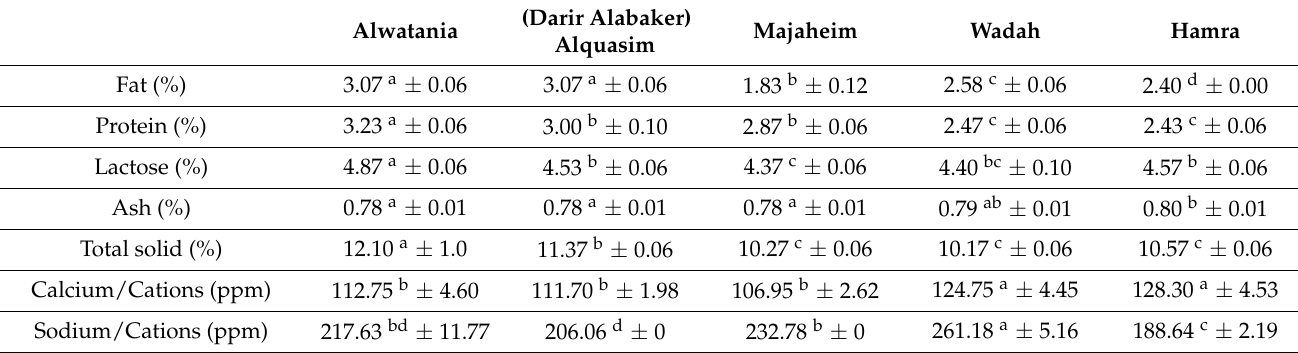
Table 1. Chemical composition of camel milk from five samples—Alwatania, Alquasim, Majaheim, Wadah, and Hamra (%: g per 100 g of milk sample). a–d Different letters in the same line indicate significant differences ( p < 0.05) between camel milk